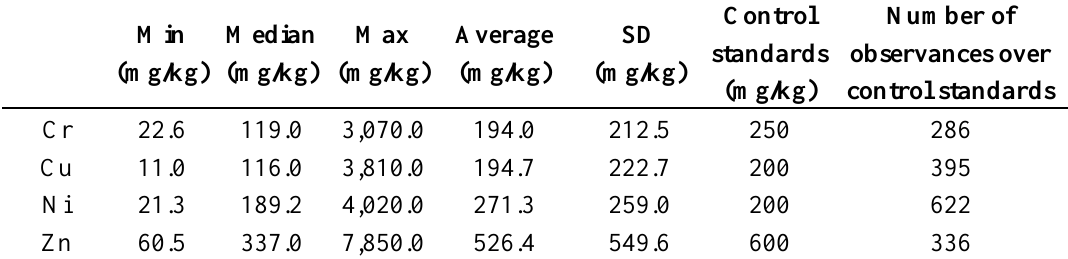
Table 1. Descriptive statistics of heavy metals for 1,082